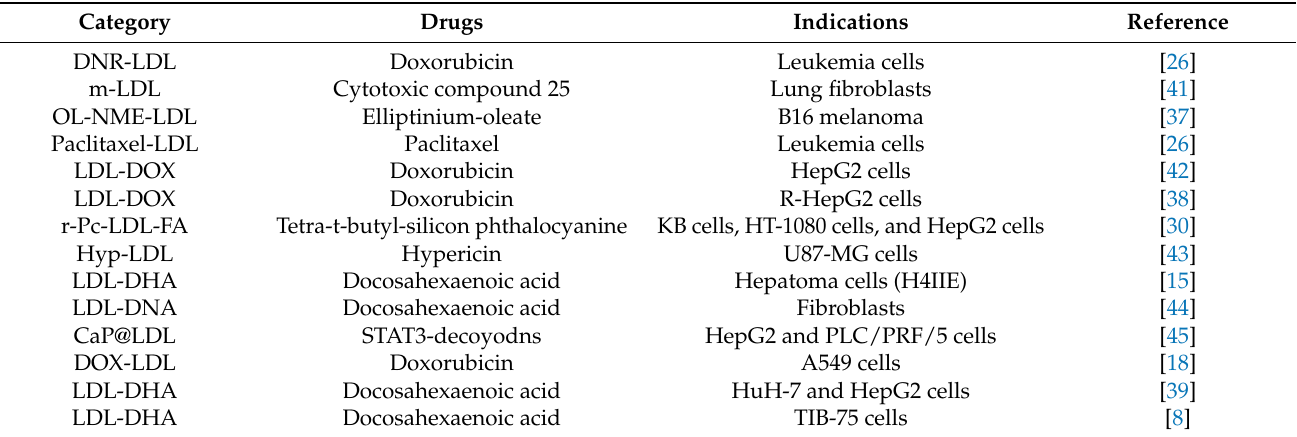
Table 2. nLDL-drugs and